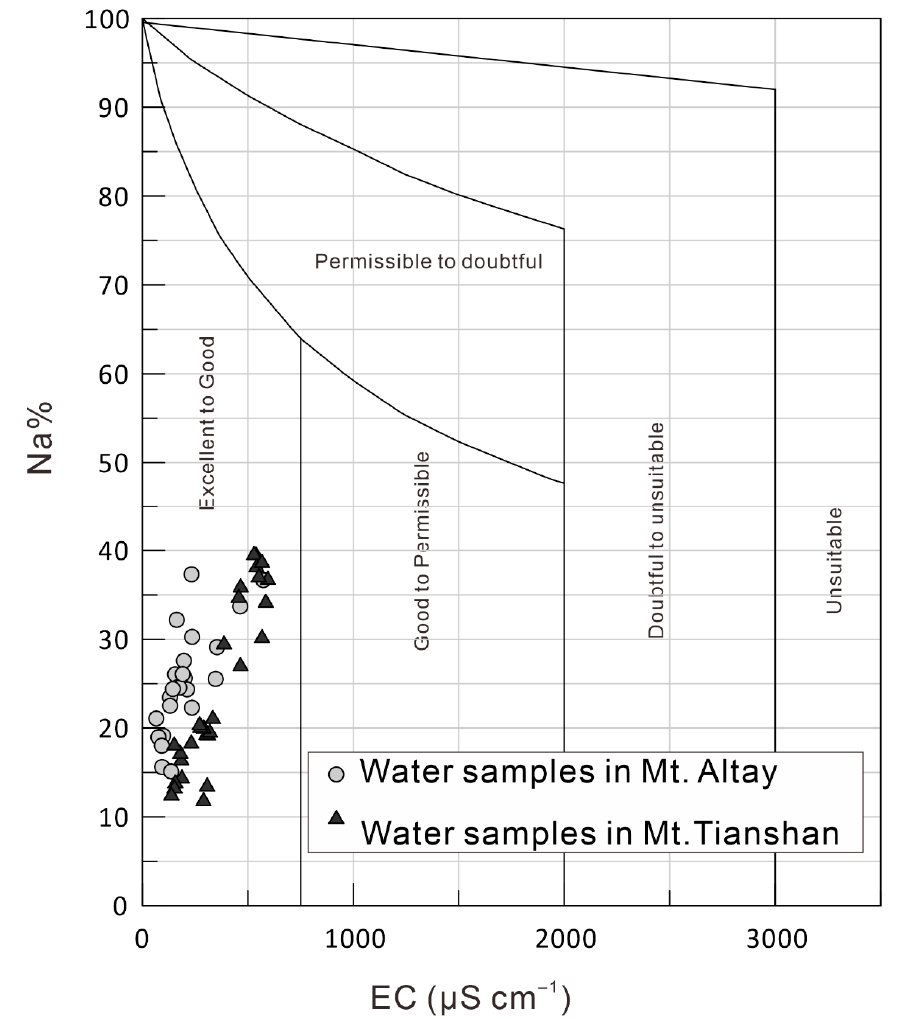
Figure 6. The irrigation assessment for the water samples from the regions of the Tianshan and Altay Mts. using a Wilcox diagram.